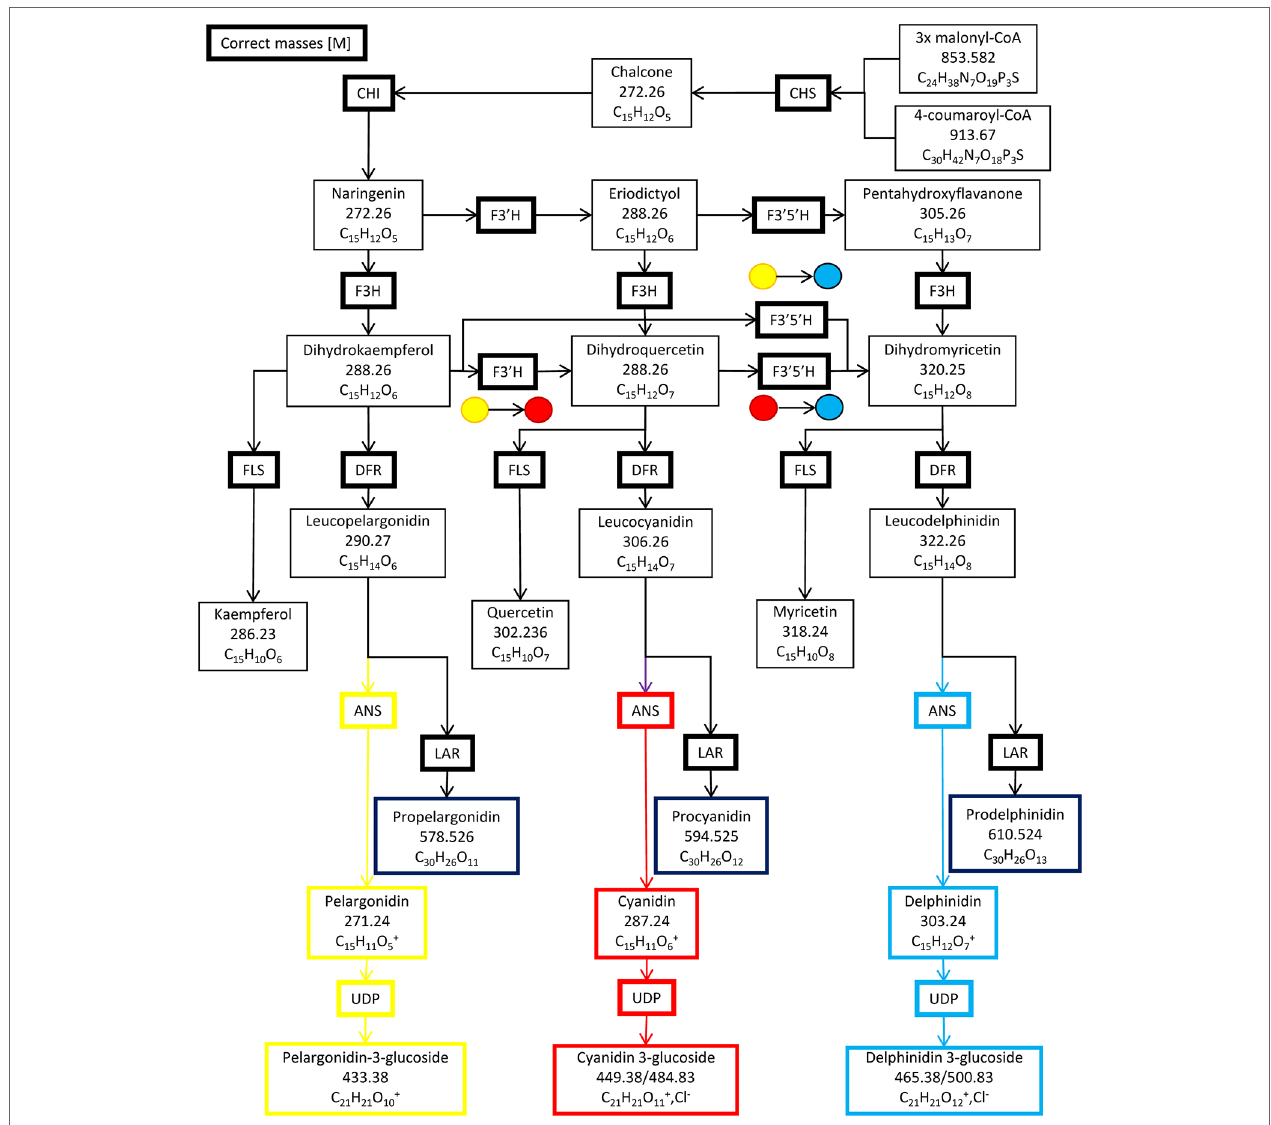
FIGURE 1 | The anthocyanin biosynthesis pathway and side branches. Chalcone synthase (CHS), chalcone isomerase (CHI), flavanone hydroxylase (F3H), flavonoid 3′ hydroxylase (F3′H), flavonoid 3′, 5′ hydroxylase (F3′5′H) dihydroflavanol-4-reductase (DFR), anthocyanin synthase (ANS), UDP 3-O-gylcosyltransferase (UDP- GST), flavanol synthase (FLS) and leucoanthocyanidin reductase